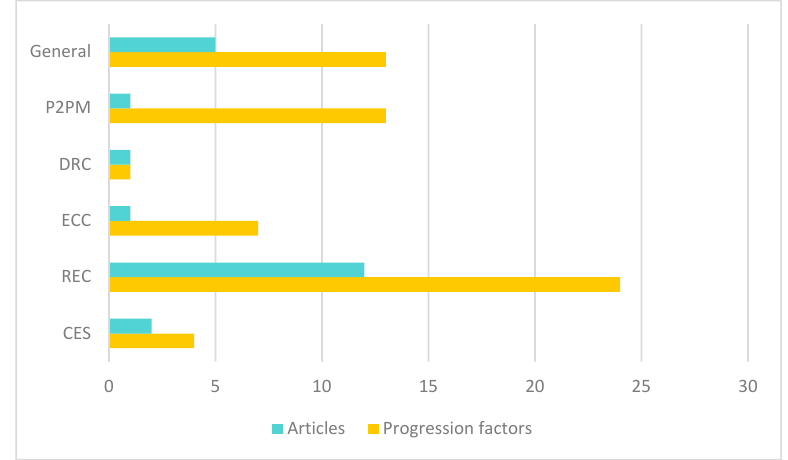
Figure 16. Progression factor distribution by use-case.